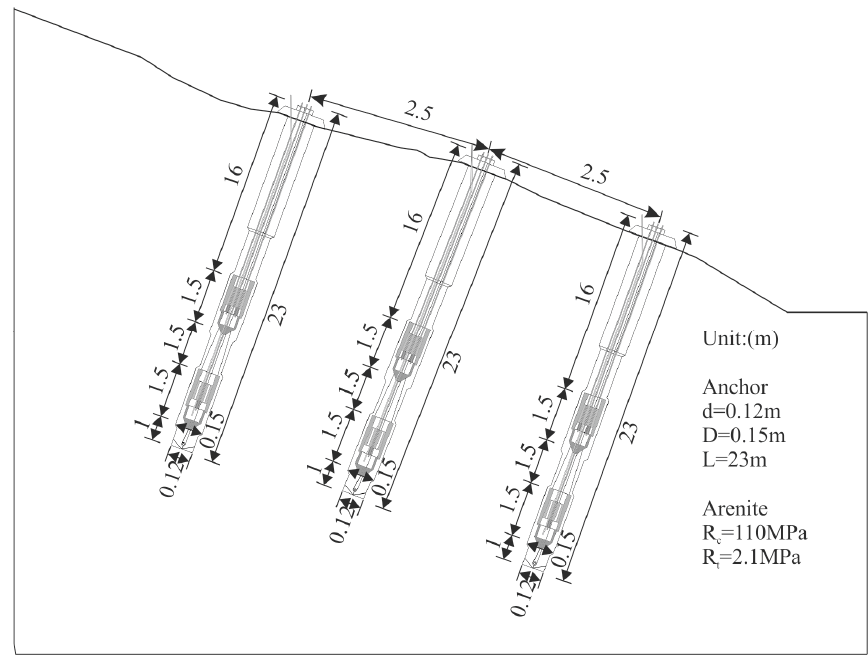
Figure 2. A schematic diagram of field tests.